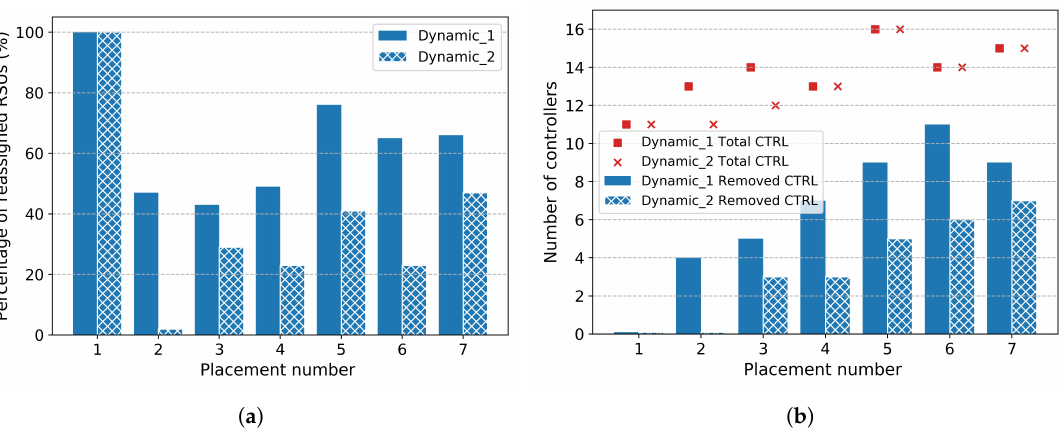
Figure 12. Minimize replacement variations. ( a ) Percentage of reassigned RSUs; ( b ) Number of relocated